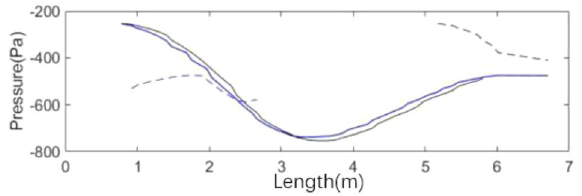
Figure 22. Development of black line vortex.